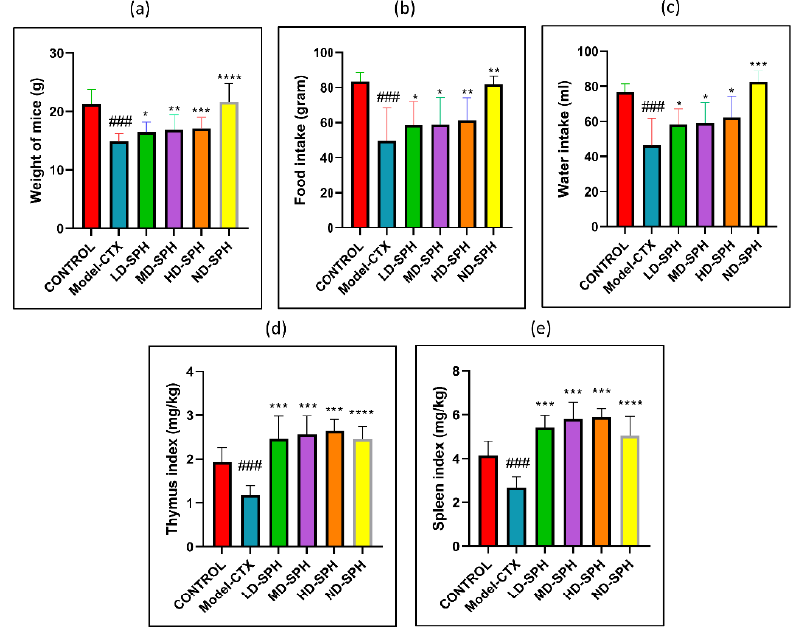
Figure 2. SPH effect on body weight, food and water intake, immune organ indices, and on prolifera- tion response of splenocyte in CTX treated mice (6 groups, n = 10.) ( a ) Bodyweight. ( b ) Water intake. ( c ) Food Intake. ( d ) Spleen index. ( e ) Thymus index. ### p < 0.001 comparison to the Normal control group. * p < 0.05, ** p < 0.01, *** p < 0.001, and **** p < 0.0001, comparison to the Model-CTX group.